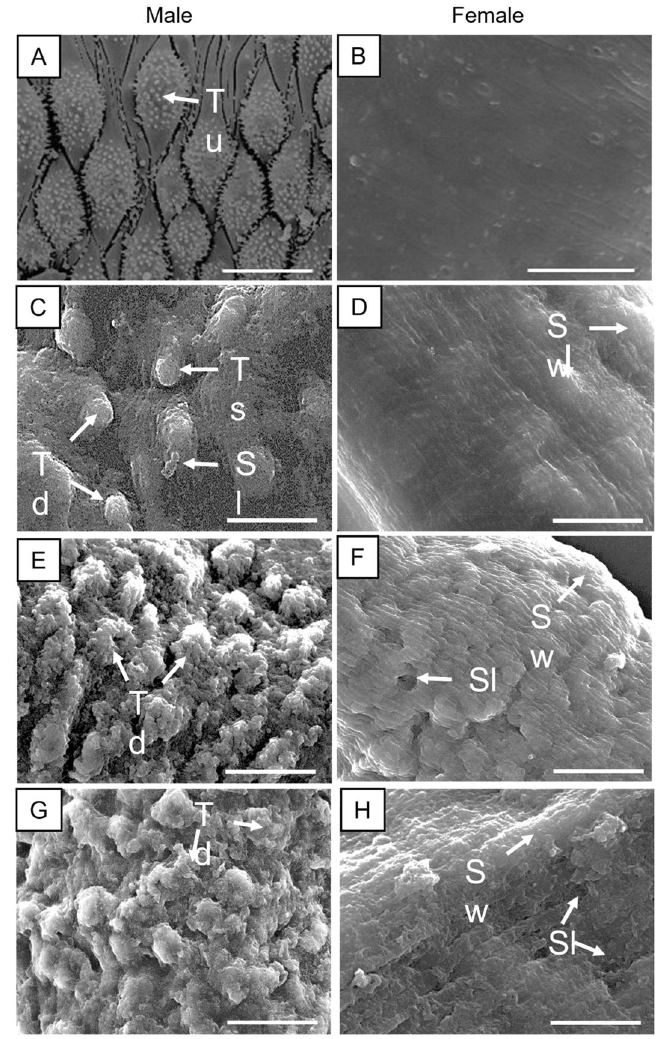
Figure 5. Scanning electron microscopy investigation of adult S. mansoni following incubation with neolignans. Control male worms showing intact tubercles (Tu) and spines on the surface (arrow) ( A ) and control female worms ( B ). Schistosomes were exposed to threo -austrobailignan-6 at 50 µM ( C and D ) or verrucosin at 25 µM ( E and F ) and 50 µM ( G and H ). Male ( A , C , E , and G ) and female ( B , D , F , and H ) helminths. The dorsal tegumental surface shows tubercle shortening (Ts), swelling (Sw), sloughing (Sl), and tubercle disintegration (Td). Images were captured using a JEOL SM 6460LV scanning electron microscope. Scale-bars: 10